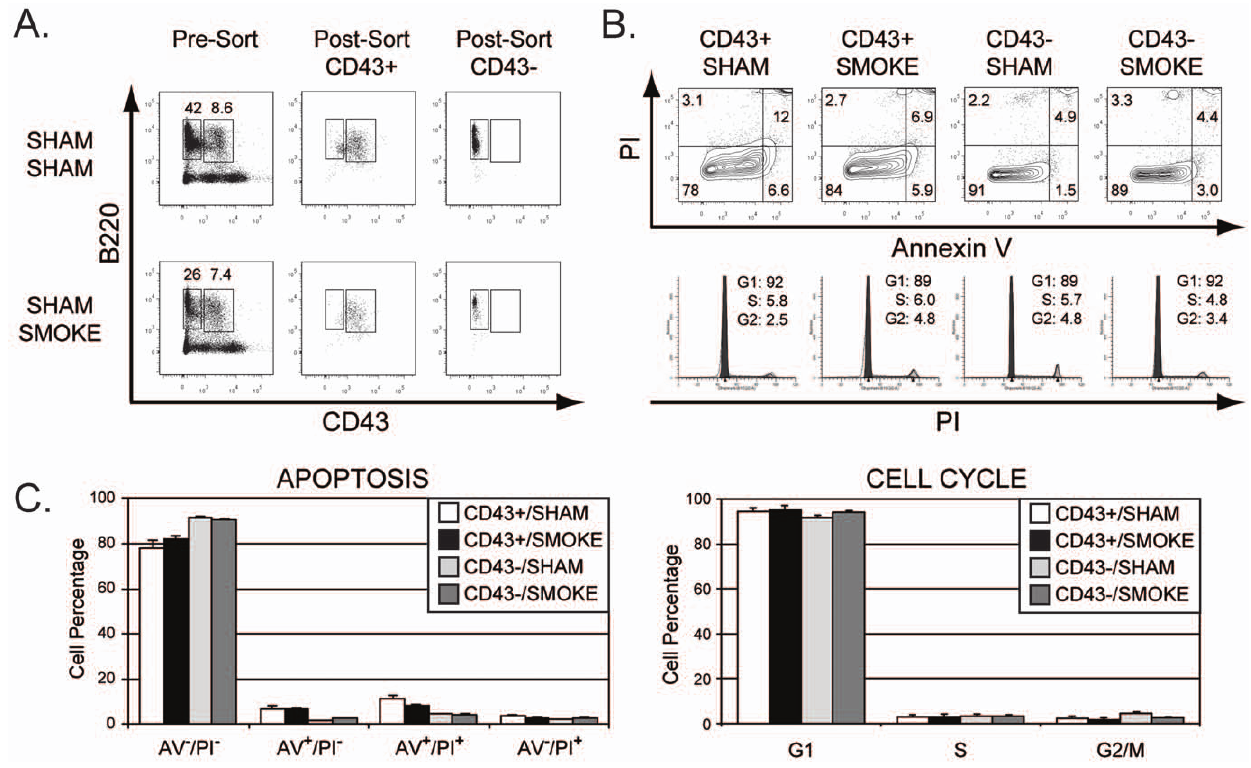
Figure 3. Apoptosis and cell cycle status in the B220 + CD43 + and B220 + CD43 2 B cell subsets are not significant altered by smoke exposure. (A) B220 + CD43 + and B220 + CD43 2 B cells were purified by FACS in the sham/sham and sham/smoke treatment groups (pre- and post-sort analysis, top row), and immediately stained with annexin V (AV) and propidium iodide (PI) (middle row) to identify early [AV + PI 2 ] or late [AV + PI + ] apoptotic cells or necrotic cells [AV 2 PI + ], or stained with Vindelov’s reagent (bottom row) to analyze cell cycle status. The percentage of cells within each quadrant or cell cycle phase is shown. Results are representative of 3–5 independent experiments. (B) Mean values for the data collected in panel A are plotted in bar graph format (C). No statistically significant differences between treatment groups were